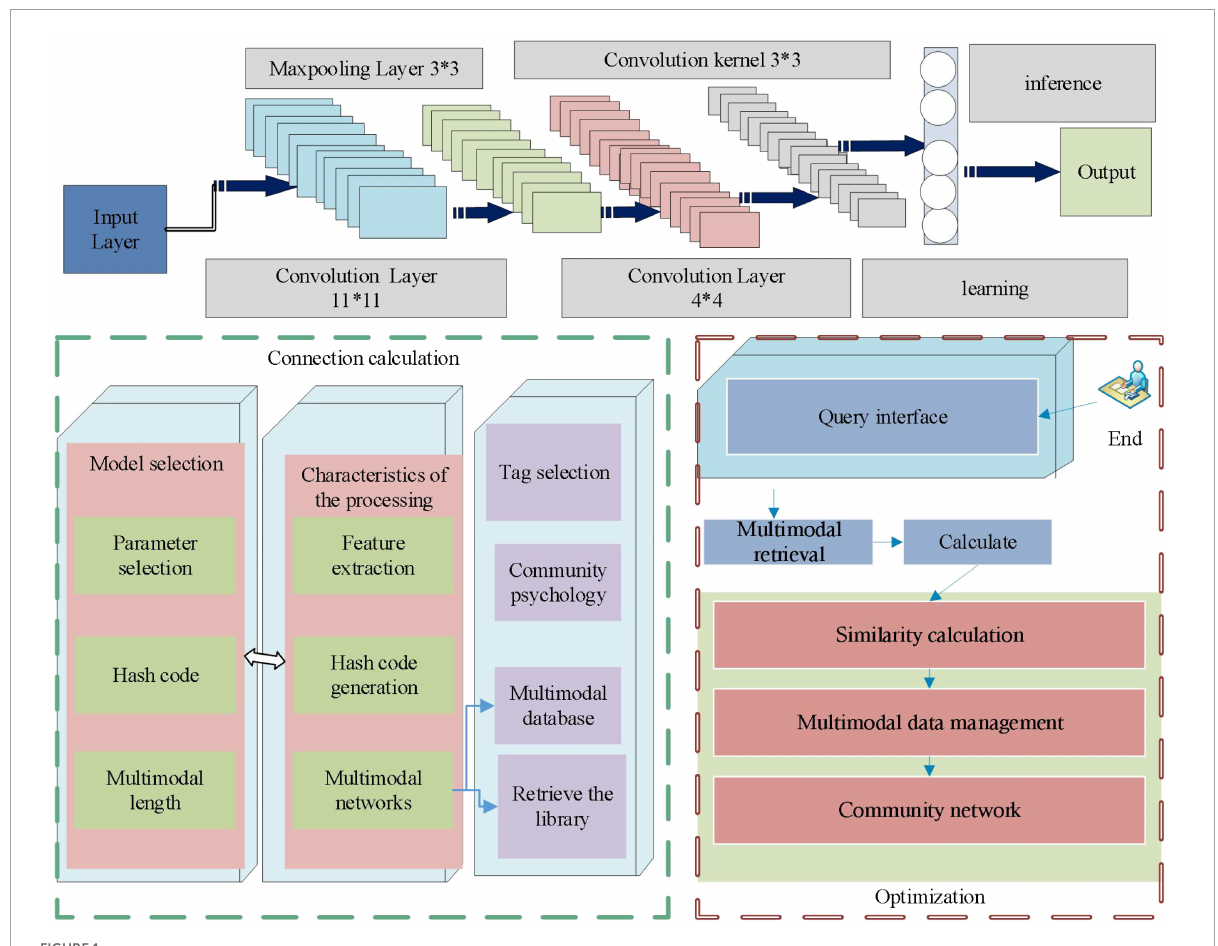
FIGURE1 Structure diagram of multimodal neural network community psychological label optimization.